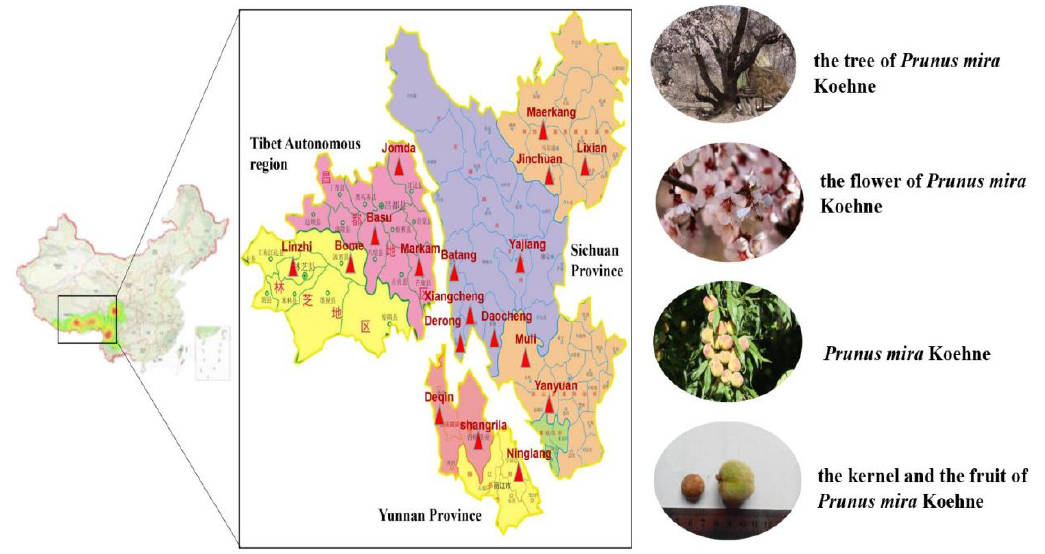
Figure 1. The distribution of P. mira in China.